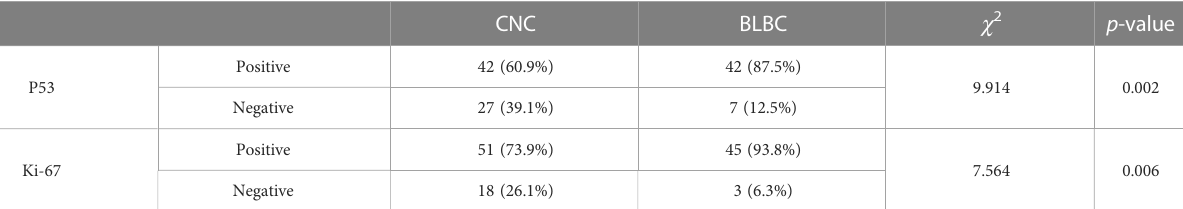
TABLE 8 Comparison of P53 and Ki-67 expression differences between CNC and